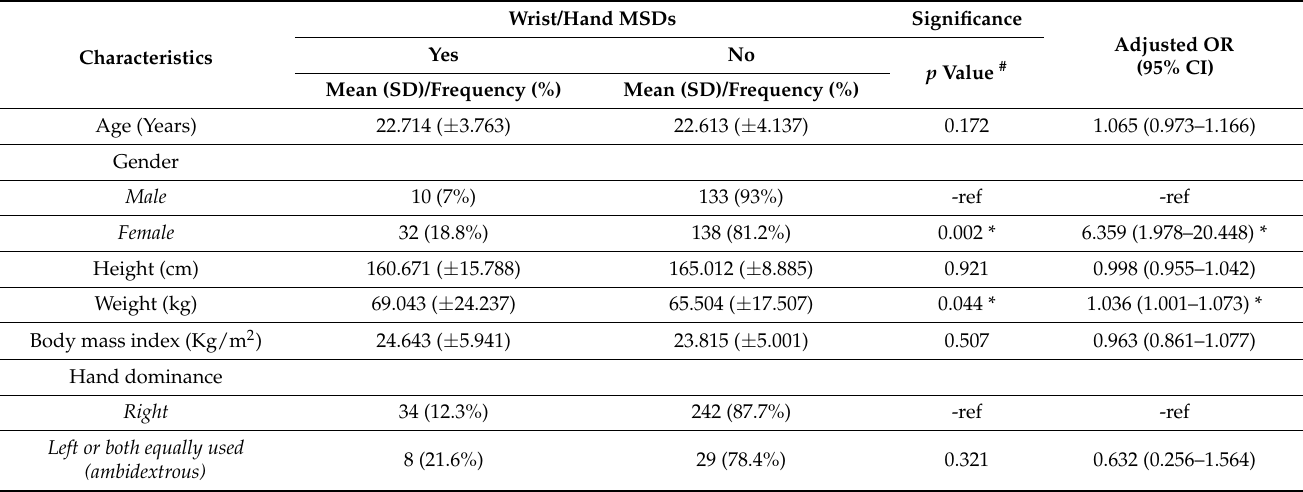
Table 7. Association between wrist/hand MSDs and participant